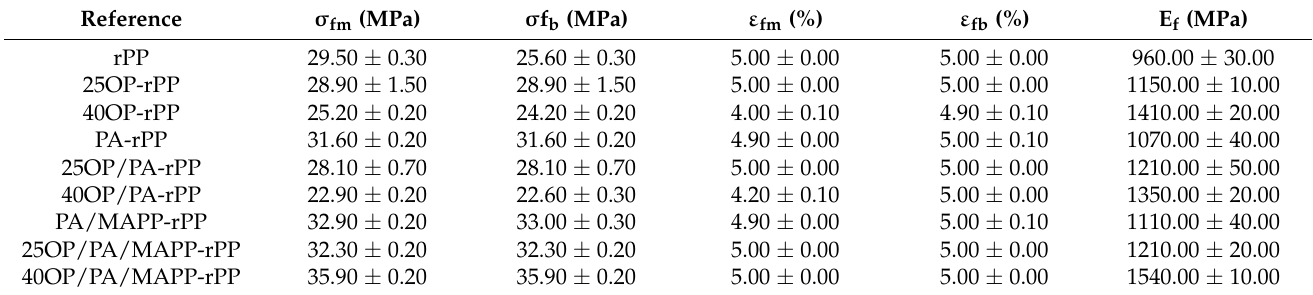
Table 5. Flexural properties of biocomposites.